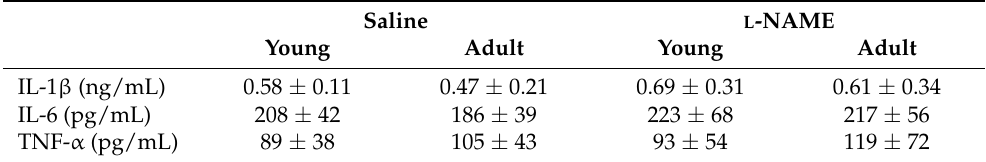
Table 1. Changes in plasma levels of proinflammatory cytokines in young (8 weeks) and adult (20 weeks) rats in response to i.p. infusion of saline or L